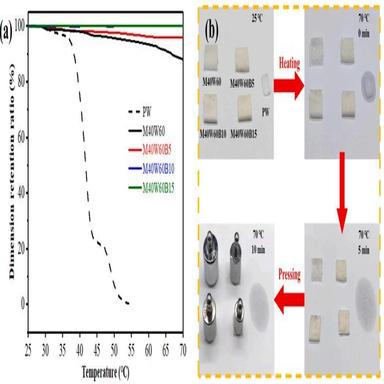
(a) Dimension retention ratios of M40W60Bx composites during the heating process under a constant pressure of 2 N; (b) digital photographs showing the encapsulation effect of M40W60Bx during the heating and pressing.